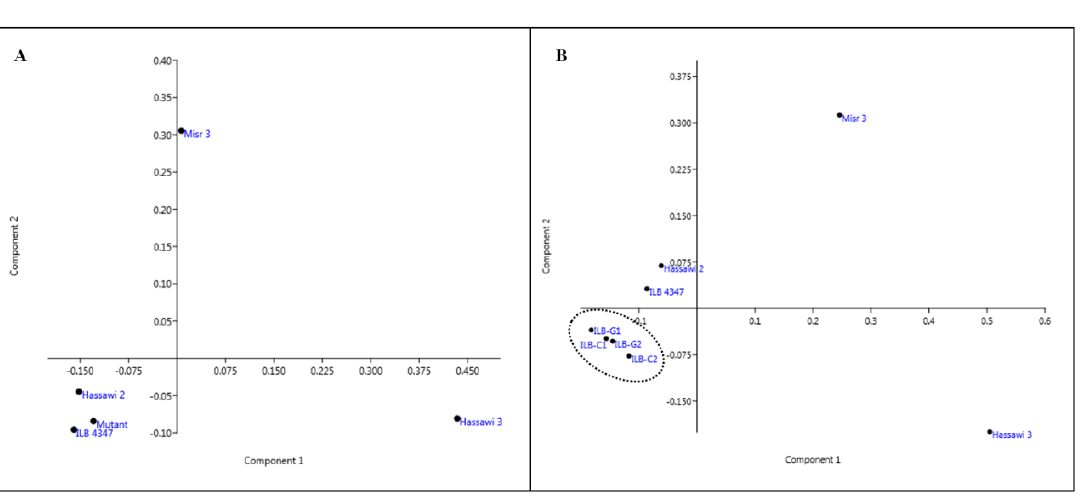
Table 5. Summary of phenotypic variation on different mutant populations.